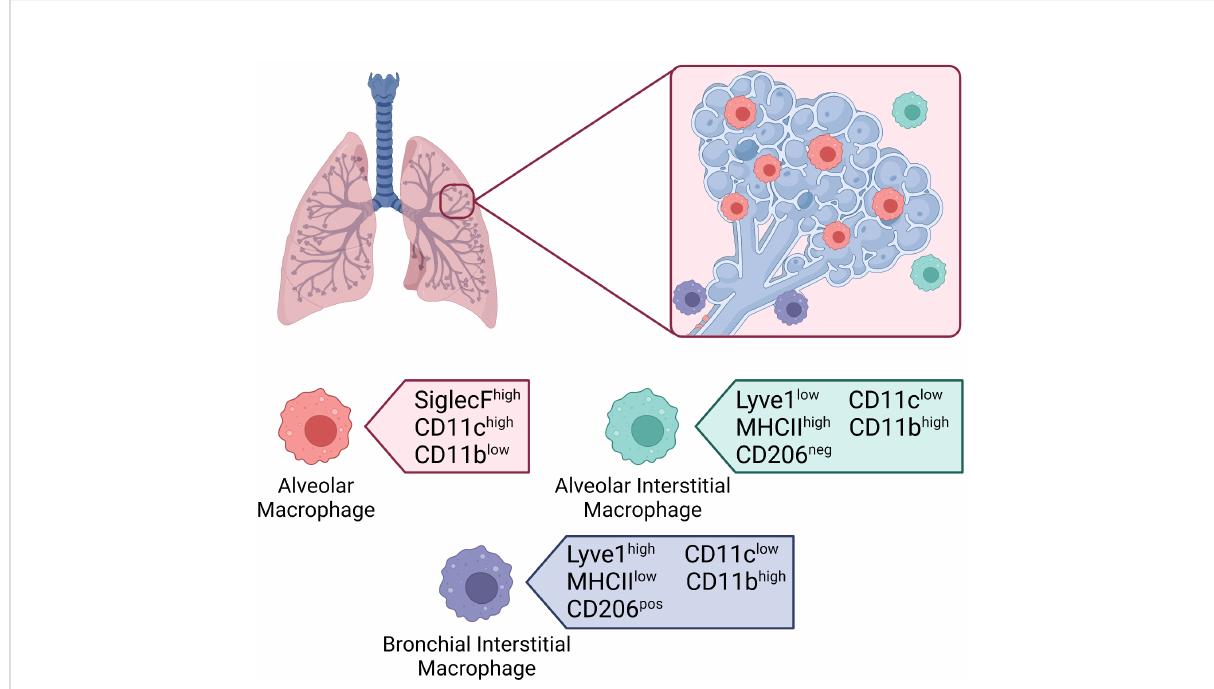
FIGURE 3 Macrophages in the lung. Location of tissue-resident macrophages in the lung and their distinguishing surface markers at steady-state. Alveolar macrophages located within the alveolar lumen express high levels of SiglecF and CD11c, and low levels of CD11b. Interstitial macrophages located in the alveolar interstitium express low levels of Lyve1, high levels of MHCII, and are CD206 negative. Interstitial macrophages located in the bronchial interstitium express high levels of Lyve1, low levels of MHCII, and are CD206 positive. Both interstitial macrophage subsets express low levels of CD11c and high levels of